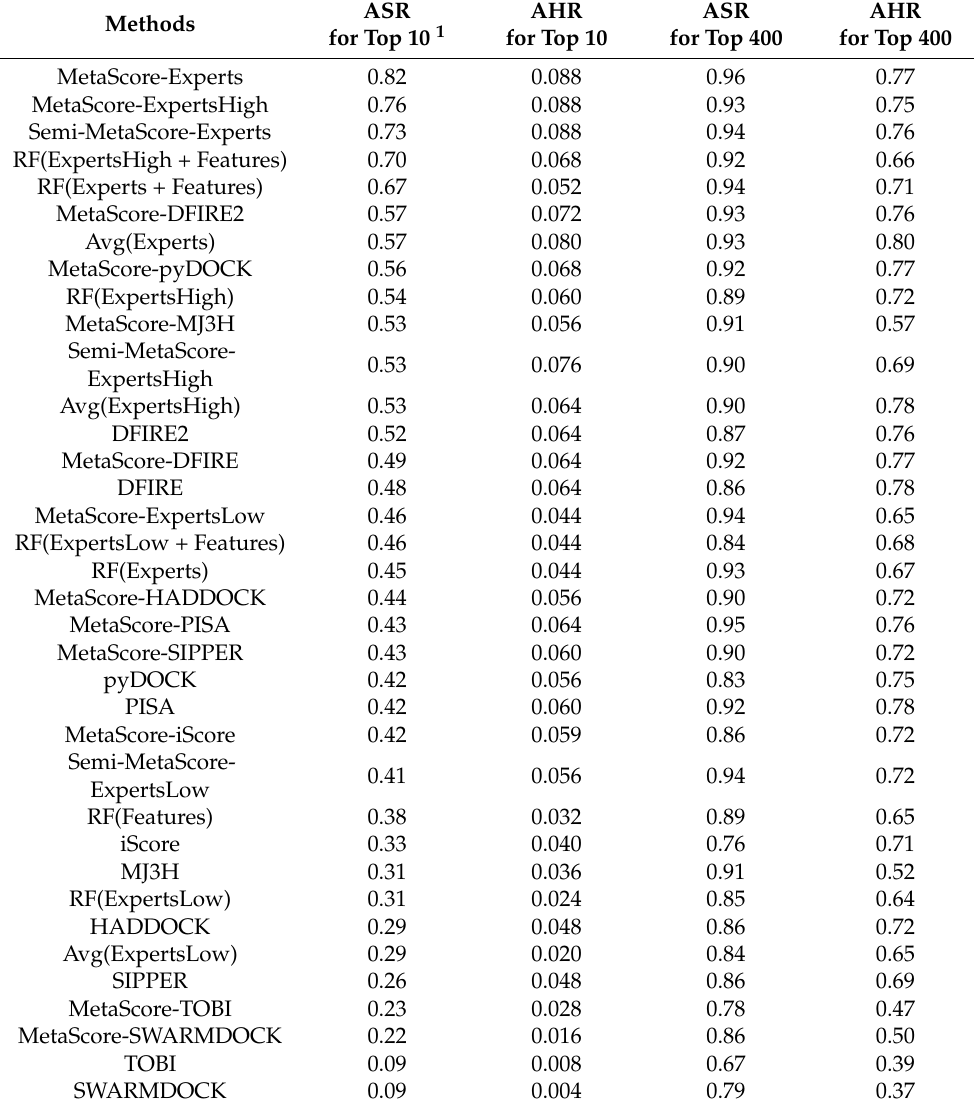
Table 5. Performance comparison of scoring methods including original methods, RF classifier variants, averaging method variants, MetaScore variants, and Semi-MetaScore variants using BM5 decoy set, which is a set of decoys generated by HADDOCK from the newly added docking cases to the protein–protein docking benchmark Version